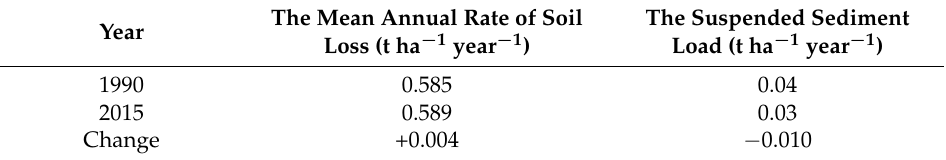
Table 2. The mean annual soil loss and suspended sediment load in 1990 and 2015.